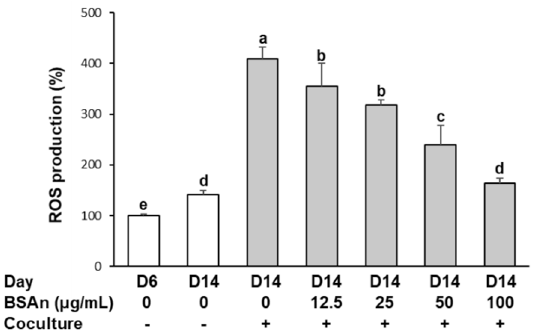
Figure 1. Effect of black soybean anthocyanin extract (BSAn) on reactive oxygen species (ROS) production in the coculture of adipocytes and macrophages. Hypertrophied 3T3-L1 adipocytes were cocultured with RAW264.7 macrophages for 24 h and then treated with BSAn for 24 h in the contact system. The level of ROS was determined by labeling with DCFH-DA, and the fluorescence intensity was analyzed by flow cytometry. Data are presented as mean ± SD of three independent experiments. a,b,c,d,e Means without the same letter are significantly different by ANOVA, followed by Duncan’s test ( p < 0.001). +: adipocytes were cocultured with macrophages, -: adipocytes were cultured alone.